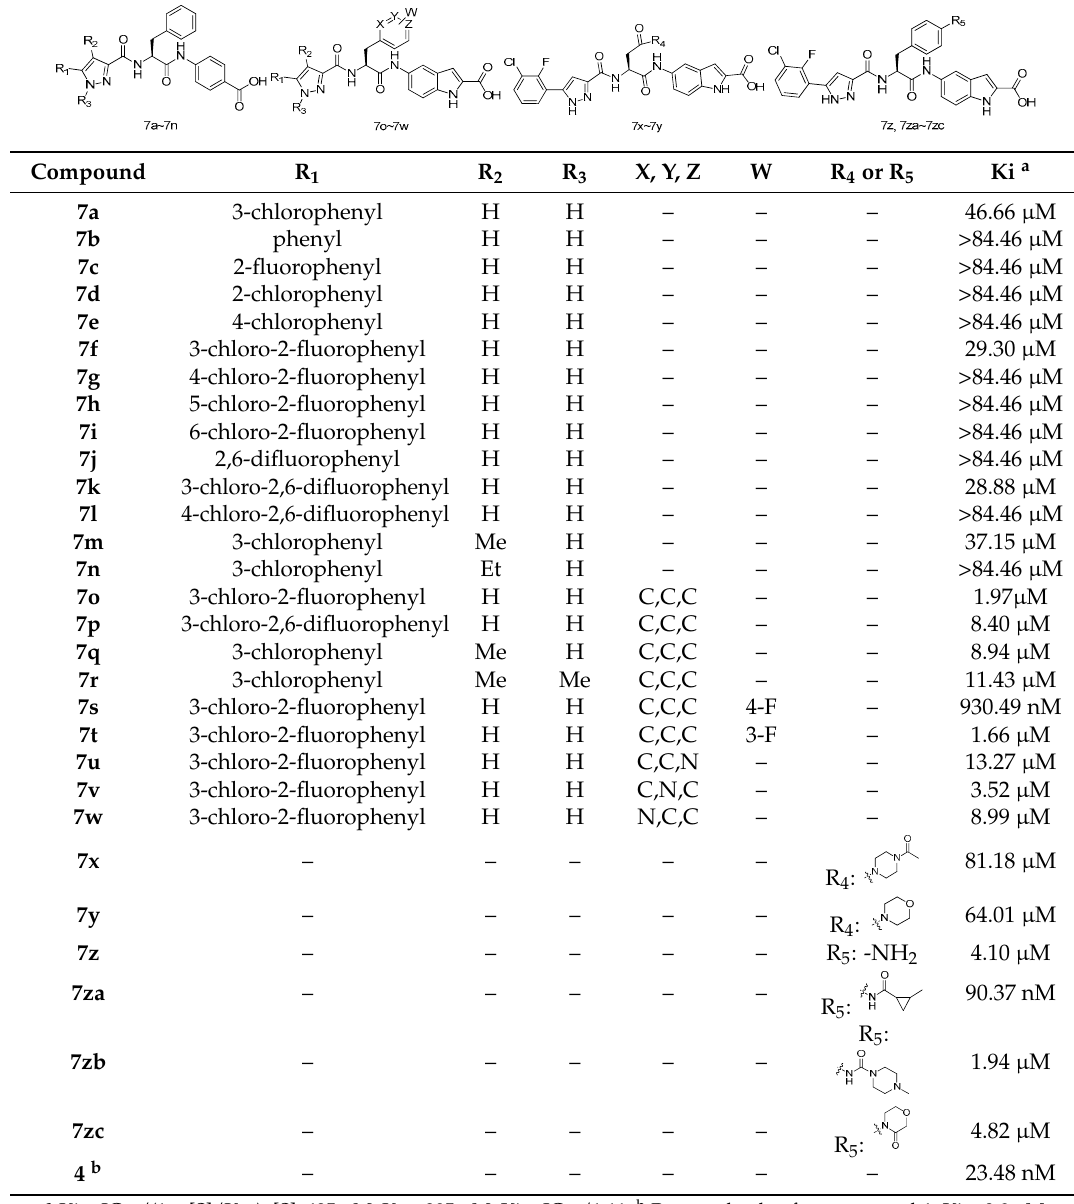
Table 1. Results of in vitro inhibitory assay of 7a – 7zc against FXIa (Ki).